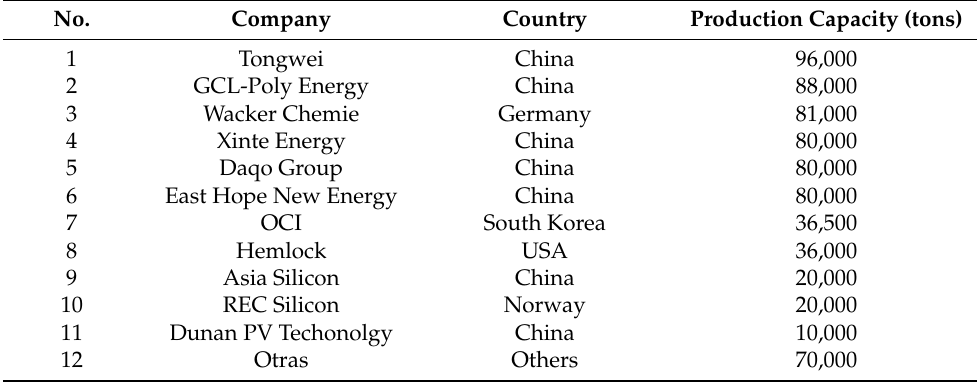
Table 1. Main Poly-Si producers in